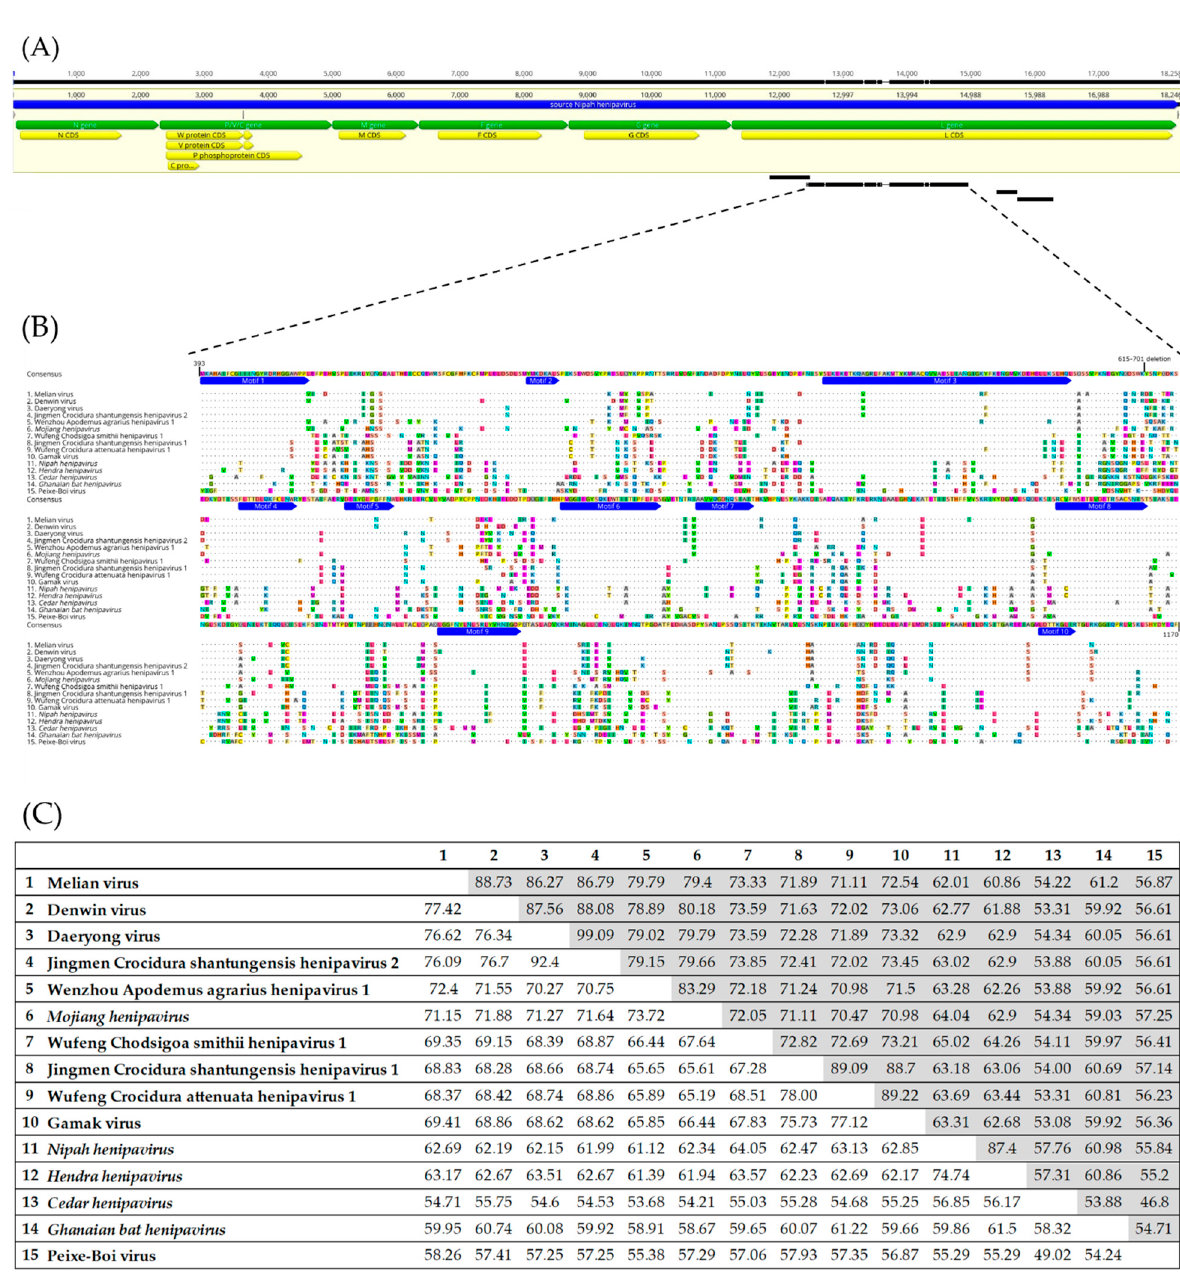
Figure 2. ( A ) Nucleotide alignment of four assembled contigs of PBV with NiV reference genome (NC_002728), and location of each contig within the L gene. ( B ) Amino acid alignment across henipaviruses and PBV sequence based on PBV partial L protein position between sites 393 and 1170 (2244 aa of NiV RefSeq). A major hypervariable region between sites 615 and 701 was deleted and ten conserved motifs are highlighted by blue annotations. ( C ) Nucleotide (white) and amino acid (gray) identities among henipaviruses and PBV.